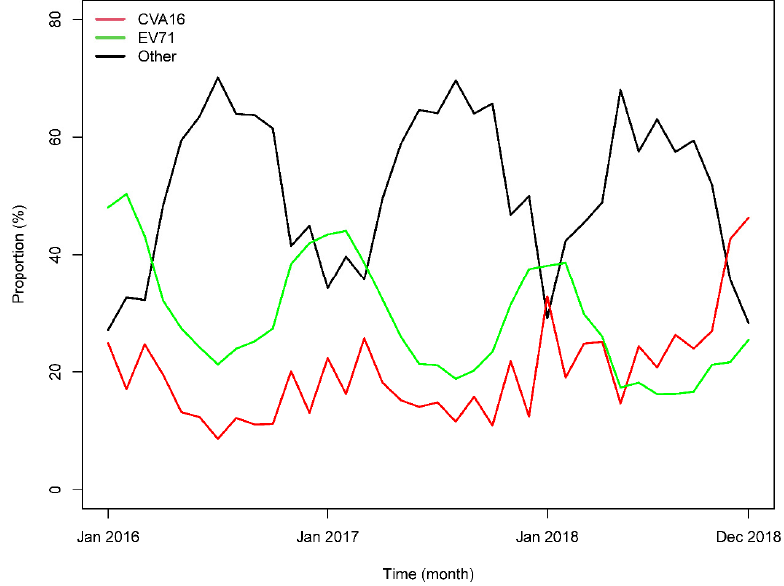
Figure 4. Fitted trends in genotype frequency of HFMD from 2016 to 2018 in Guangzhou, China.